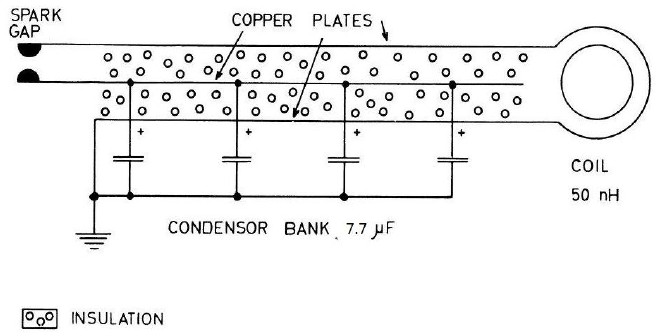
Figure 2. Schematic of the theta-pinch electric circuit. Reproduced and modified by permission of IOP Publishing from [18] (© The Royal Swedish Academy of Sciences. All rights reserved.)